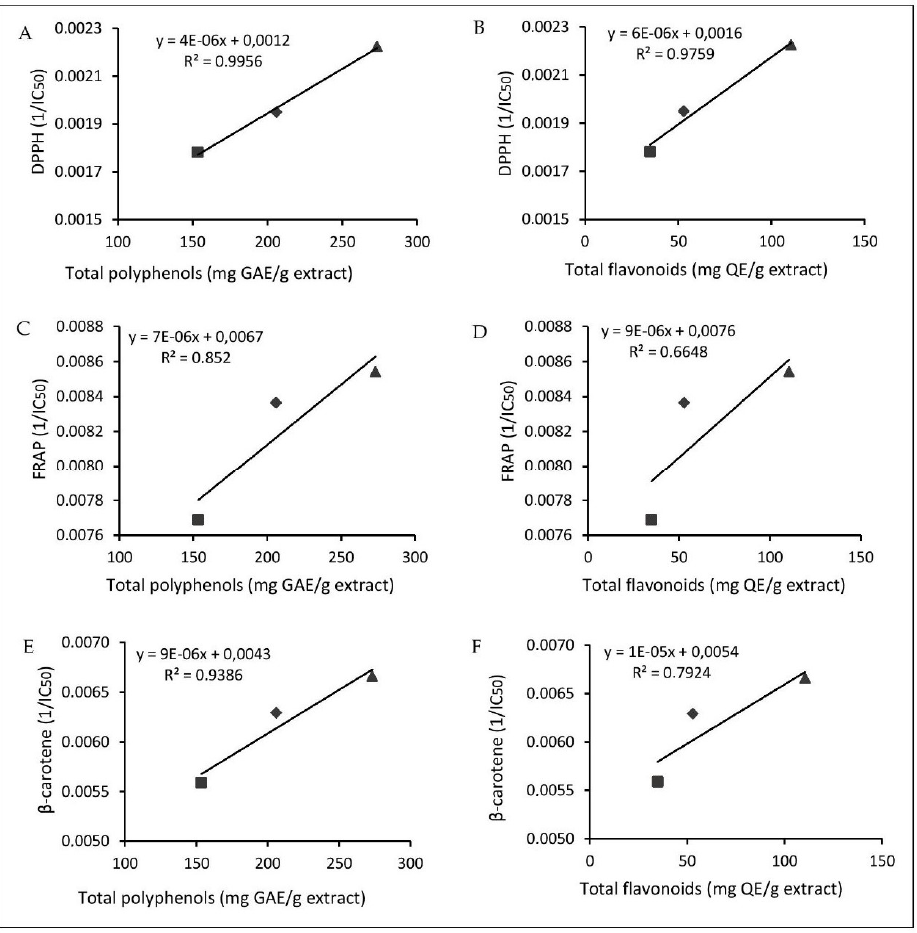
Figure 2. ( A ). Correlation between the total polyphenolic content and DPPH activity; ( B ). correlation between the total flavonoid content and DPPH activity; ( C ). correlation between the total polyphenolic content and FRAP activity; ( D ). correlation between the total flavonoid content and FRAP activity; ( E ). correlation between the total polyphenolic content and bleaching activity of β -carotene; ( F ). correlation between the total flavonoid content and bleaching activity of β -carotene; r: correlation coefficient and R 2 : determination coefficient; roots ( (cid:4) ), stems ( ), leaves ( (cid:78) ).